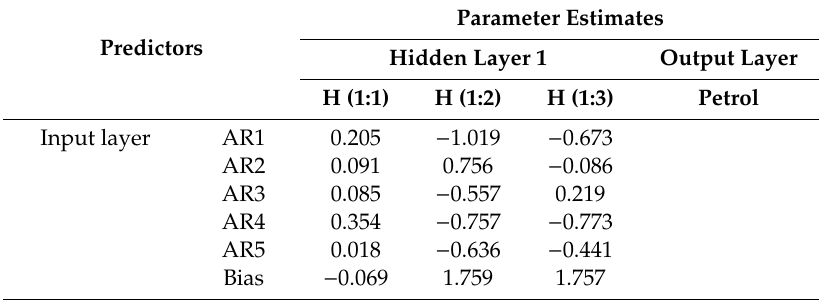
Table 8. The final ANN model summary for petrol consumption in the residential